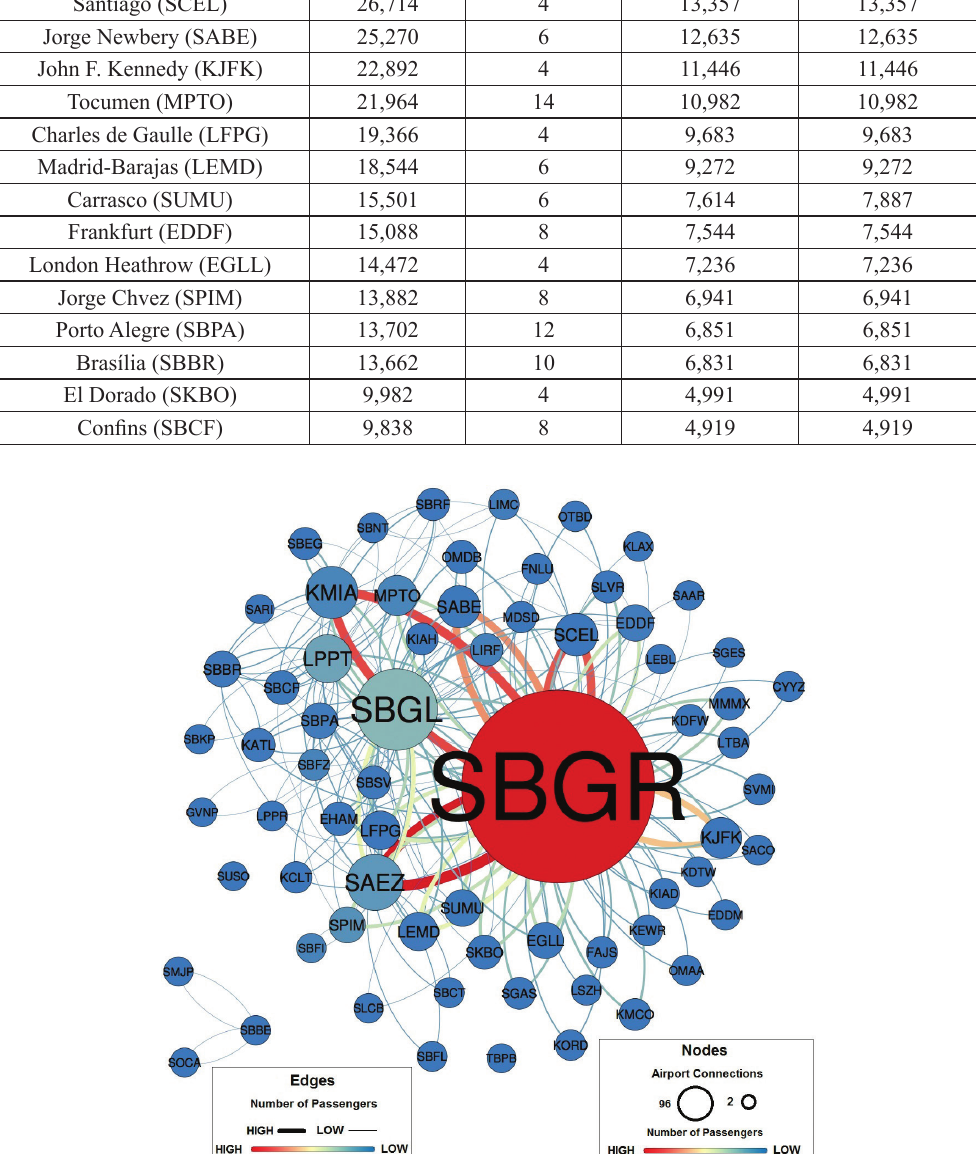
Figure 7 - Network - International Flights. For interpretation of the references to color in this figure, the reader is referred to the web version of this